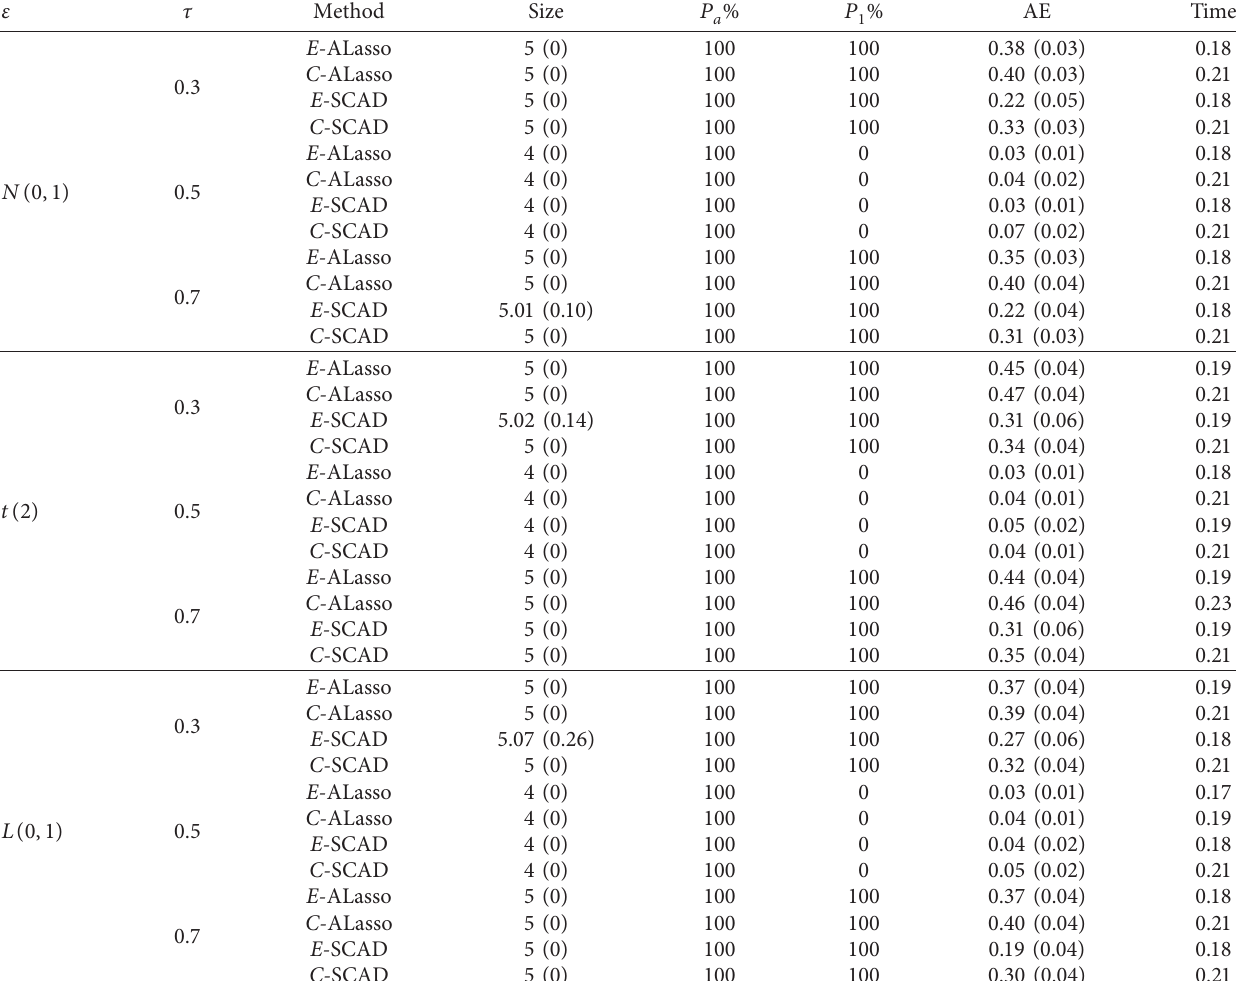
Table 1: Simulation results for k � 10 , n � 100 , p � 300 , and N � nk .